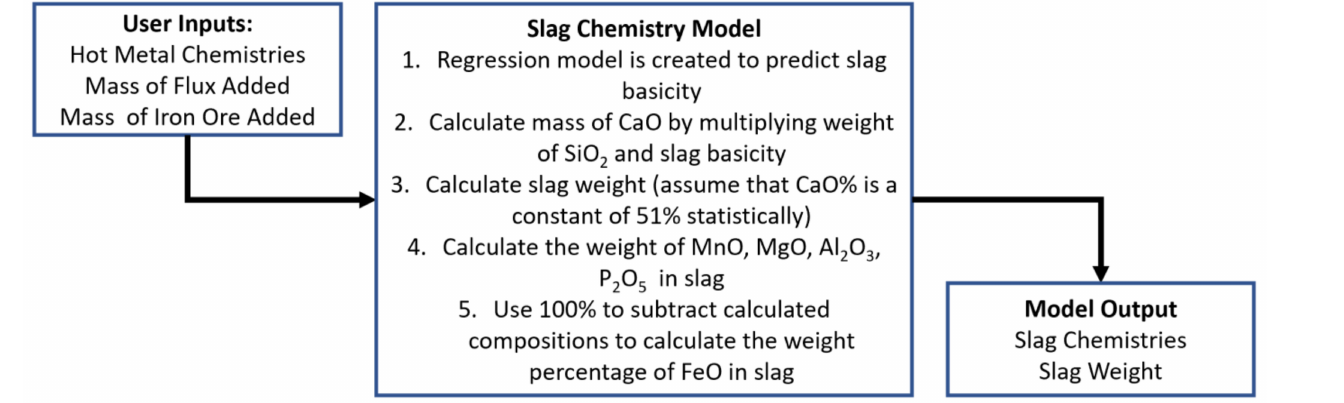
Figure 2. Flowchart of the slag chemistry model.